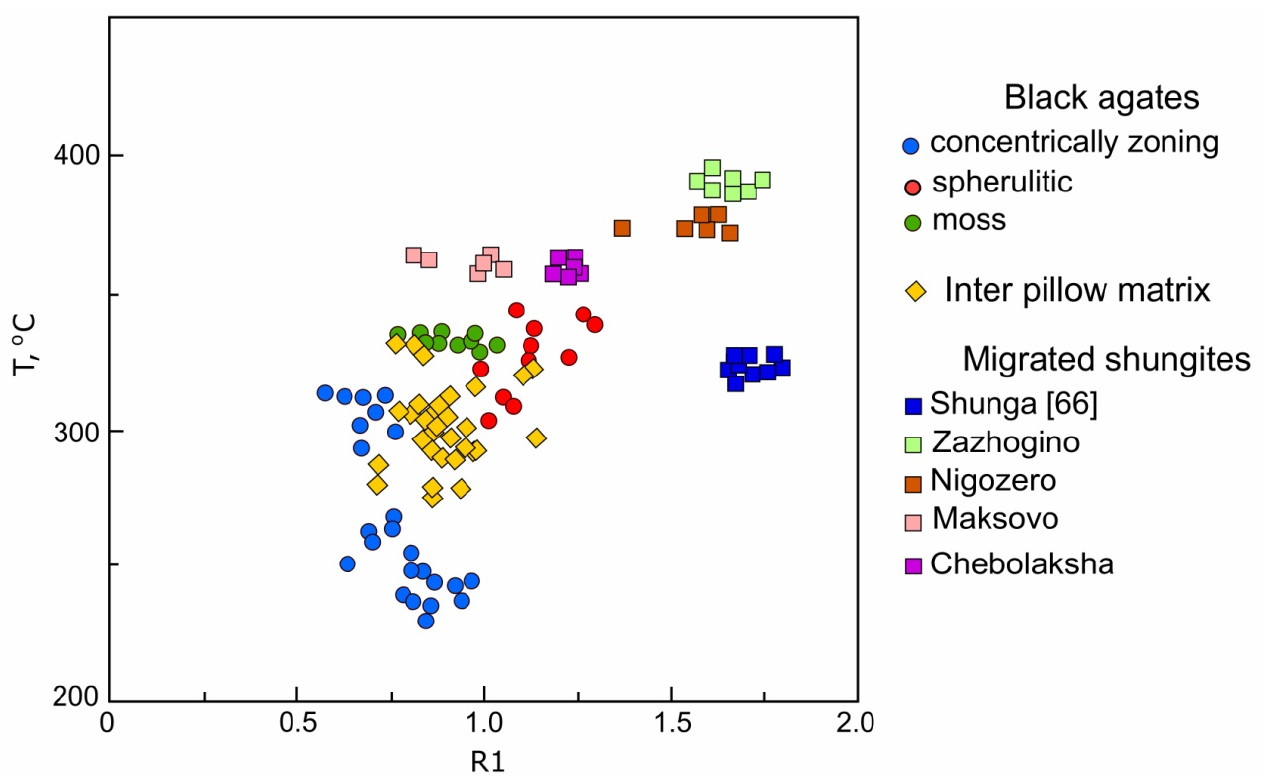
Figure 9. R1 vs. peak metamorphic temperature for the carbonaceous matter from black agates, inter-pillow matrix, and shungites from various deposits. Temperatures were calculated using the thermometer proposed by Kouketsu et al. [45]. Shunga [66].